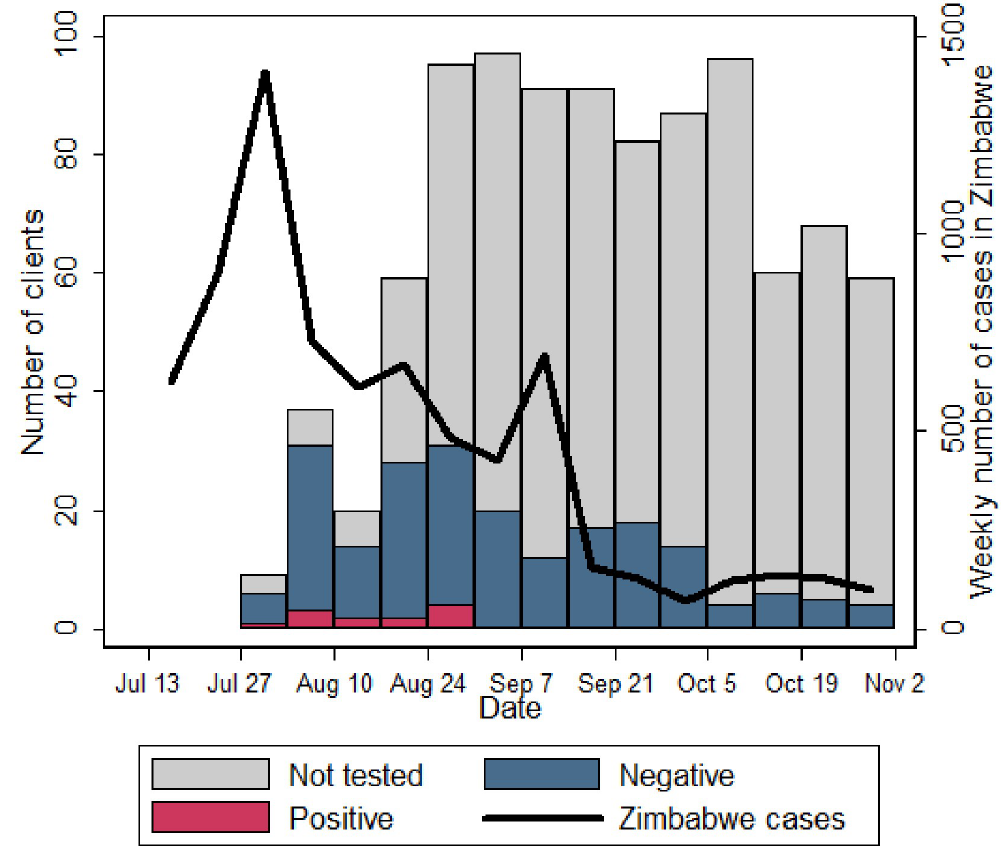
Fig 1. Numbers of healthcare workers (clients) enrolled and tested for SARS-CoV-2, overlain with weekly national case reports from Zimbabwe (all dates—2020) .